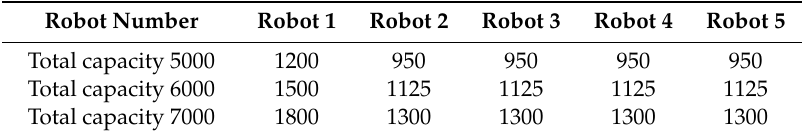
Table 2. Space-robot capacity information.